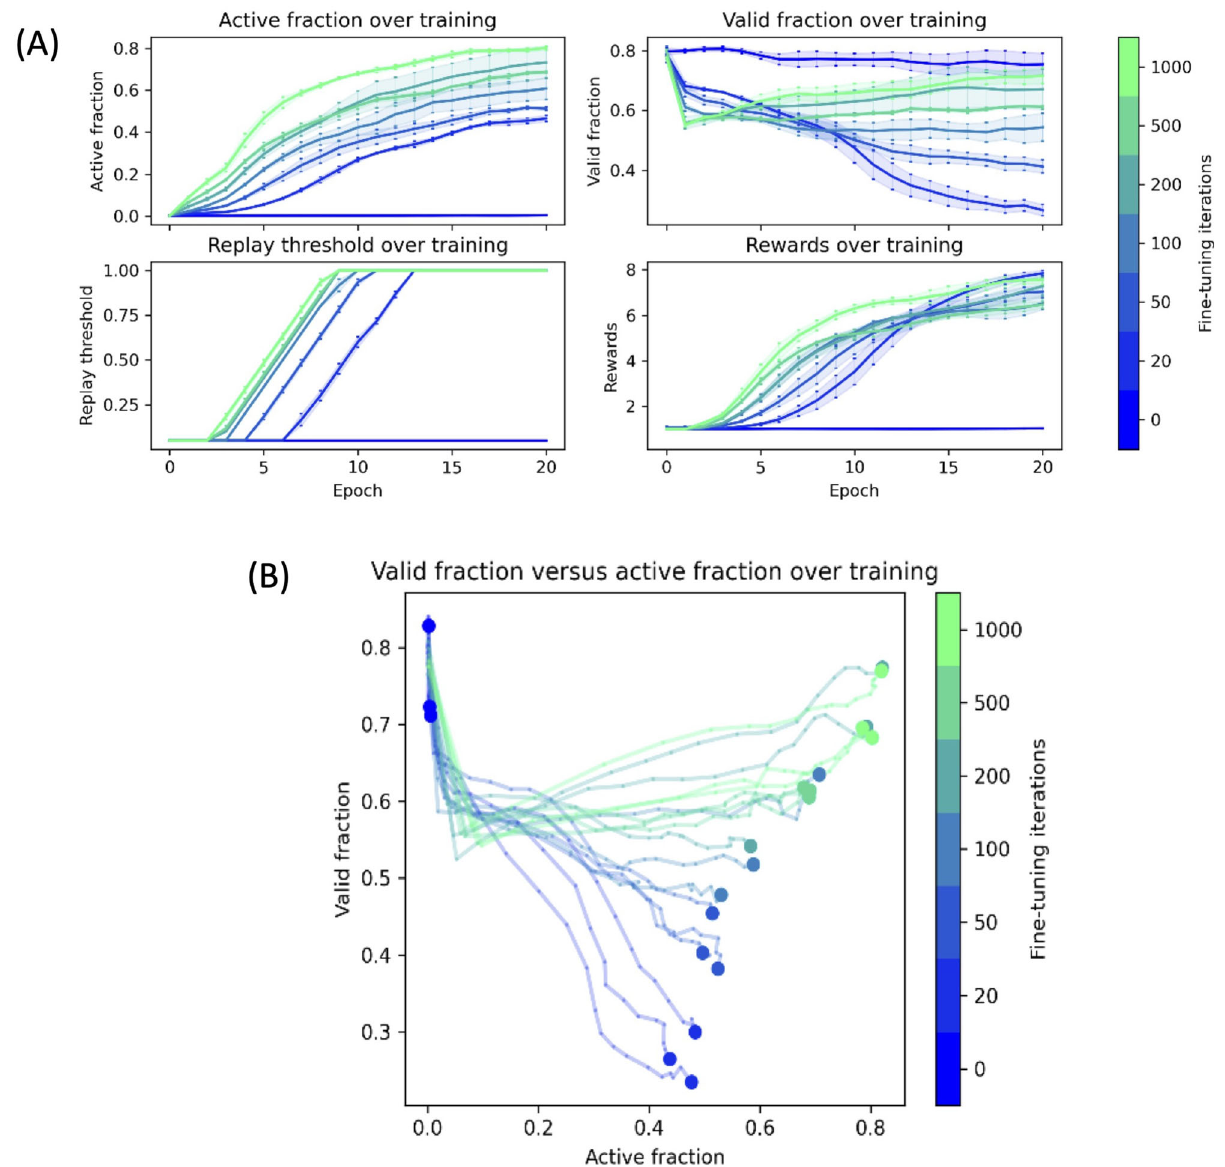
Fig. 3 Training trajectories. A Trajectory of training for different fi ne-tuning values. Models were trained with 25 iterations of policy gradient and 0, 20, 50, 100, 200, 500, or 1000 iterations of fi ne-tuning per epoch. B Evolution of active and valid fractions over training. Models were trained with 25 iterations of policy gradient and 0, 20, 50, 100, 200, 500, or 1,000 iterations of fi ne-tuning per epoch. Solid lines represent training, small dots represent data at each epoch, and large dots represent data from the fully trained model. Graphs are color-coded by the number of fi ne-tuning iterations used per